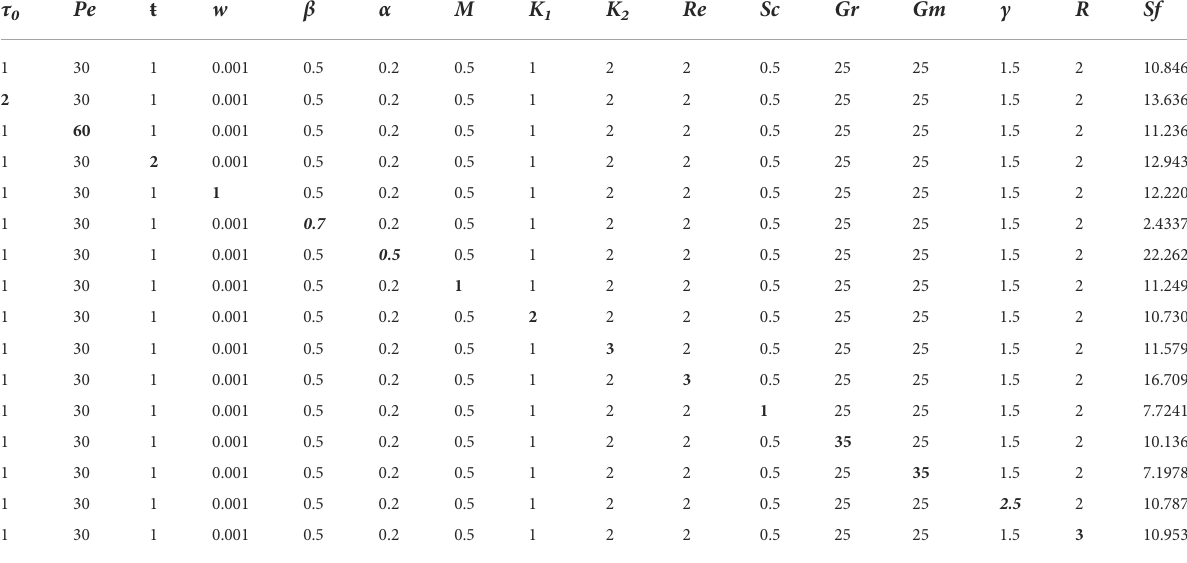
TABLE 1 The behaviour of the skin friction with the variation of parameters on the left